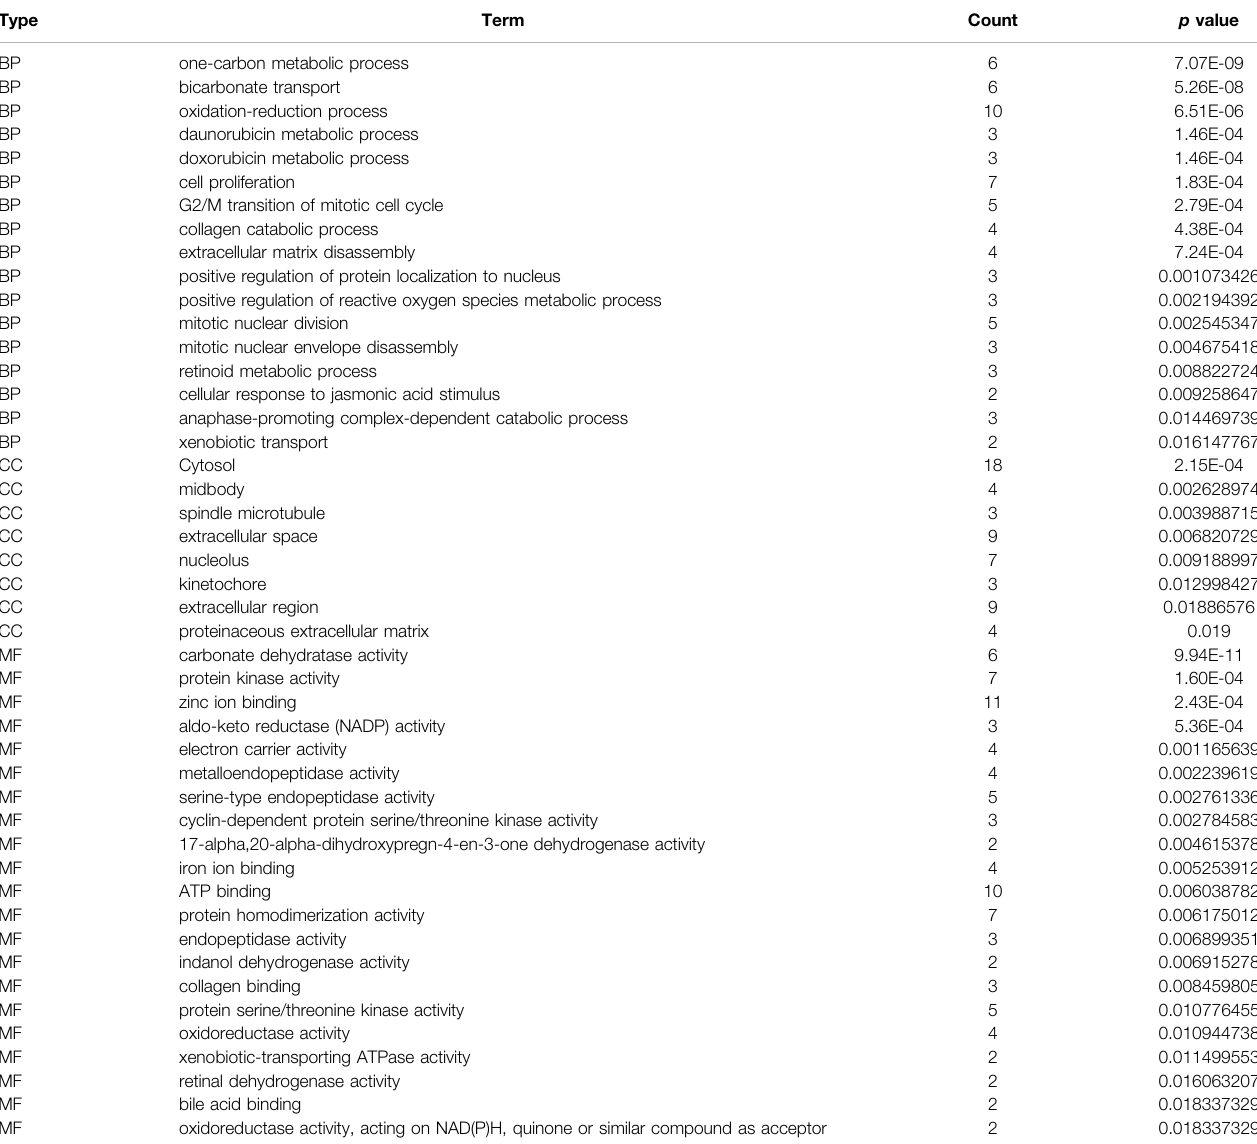
TABLE 2 | The biological functions of 40 differentially expressed target genes were explored in the DAVID